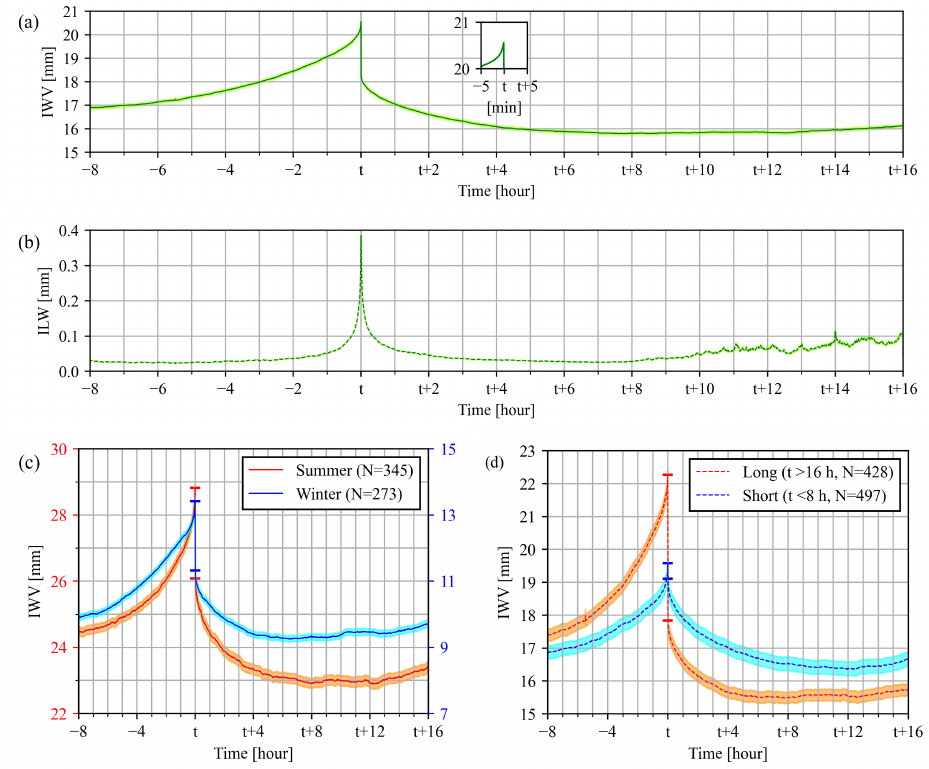
Figure 1. Composites of ( a ) integrated water vapor (IWV, green solid line) and ( b ) integrated liquid water (ILW, green dashed line) 8 h before and 16 h after rain, ( c ) the IWV composites in summer ( N = 345) and winter ( N = 273), as well as ( d ) the IWV composites for long ( N = 428)- and short ( N = 497)-duration rain events. The subplot is from 5 min before rain to 5 min after rain. IWV and ILW acquired by the TROpospheric WAter RAdiometer (TROWARA) in Bern. The shaded area shows √ n ). Time t is the duration of rainfall. Short the standard deviation of the mean (error of the mean σ / horizontal lines mark the beginning and end of